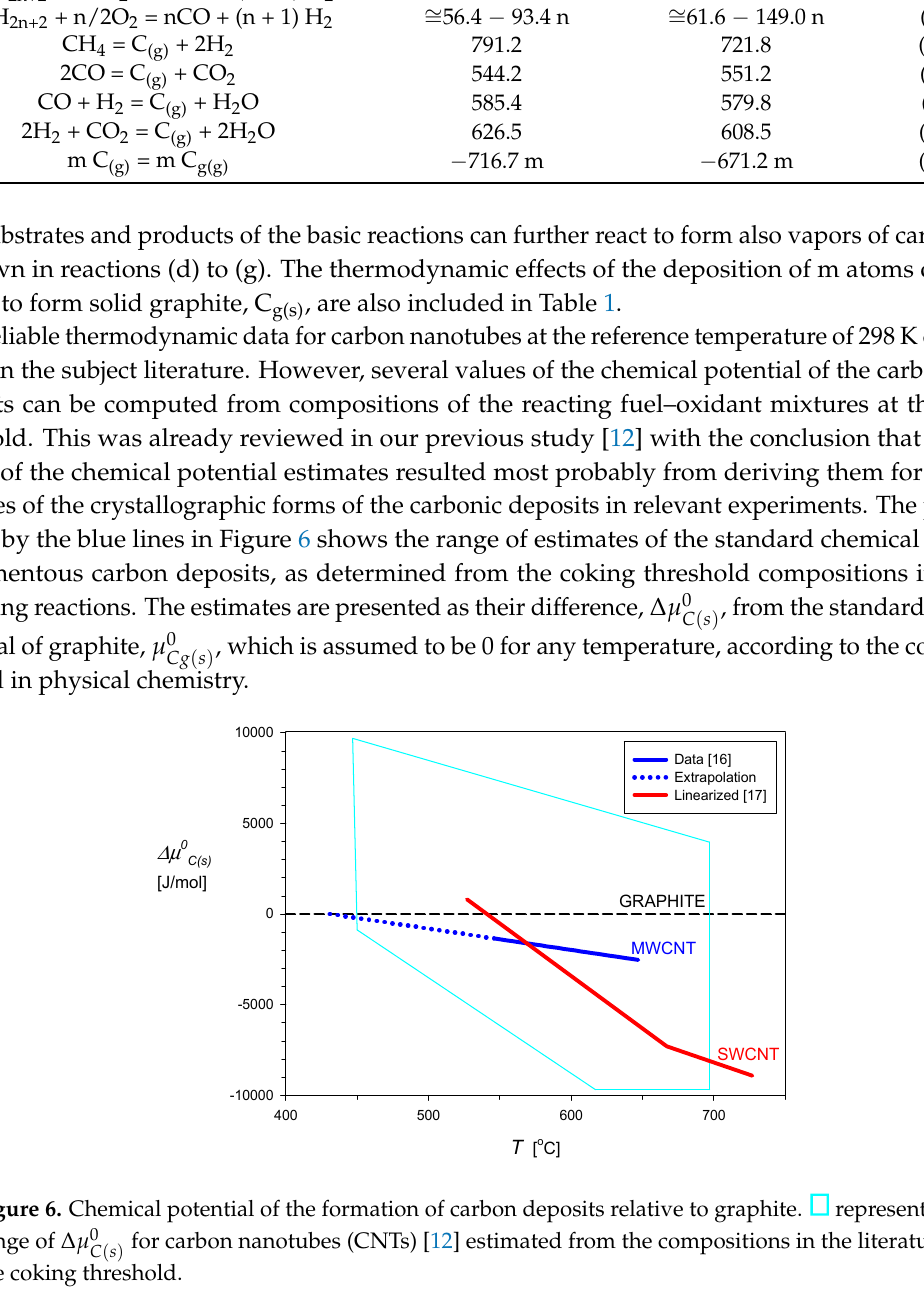
Table 1. Basic reactions and their standard thermodynamic data.